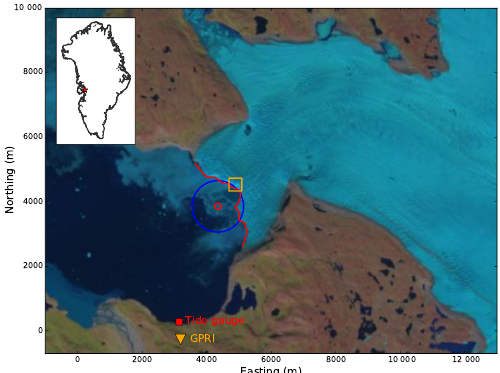
Figure 1. Satellite image (Landsat, 3 July 2014) illustrating the po- sitions of the glacier calving front (red line) and the locations of TRI and the tide gauge. The orange square shows the part of the ice front that collapsed on 2 July 2014. The position of a tour boat during the ice front collapse is indicated by a red circle; the blue circle marks 800m distance from the boat. (Polar Stereographic projection, off- sets with respect to 206000,